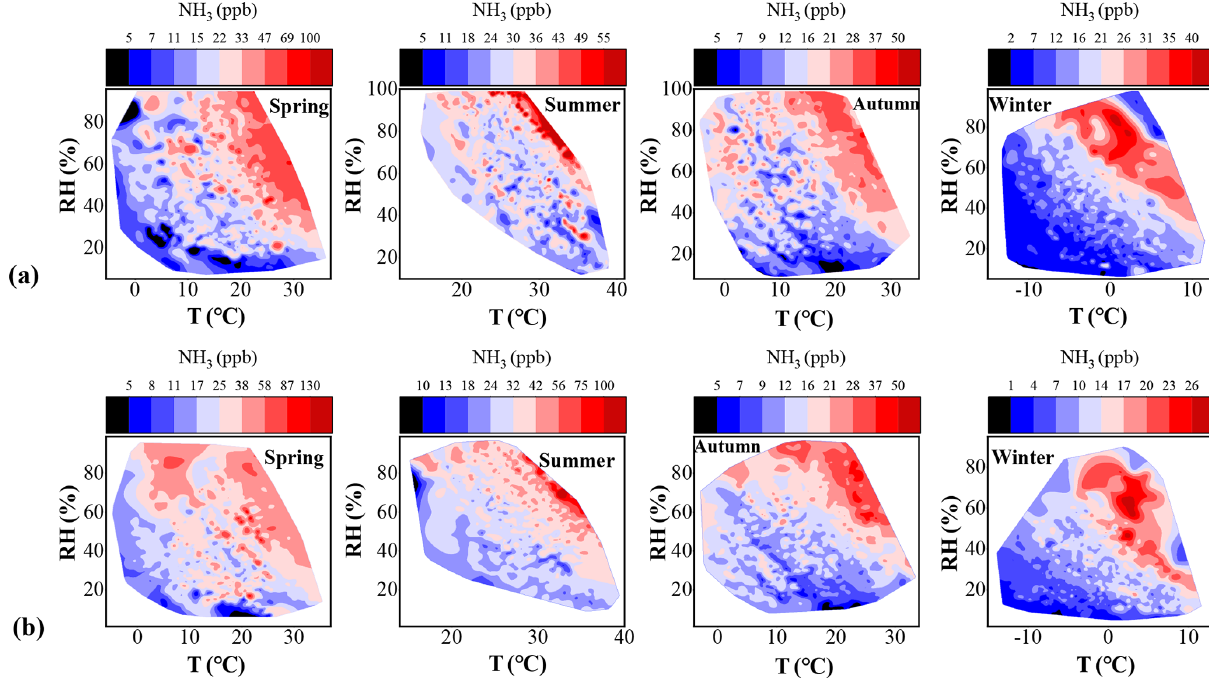
Figure 6. Contour maps of the NH 3 mixing ratio, temperature, and relative humidity in different seasons at the (a) urban and (b) suburban sites in Beijing.